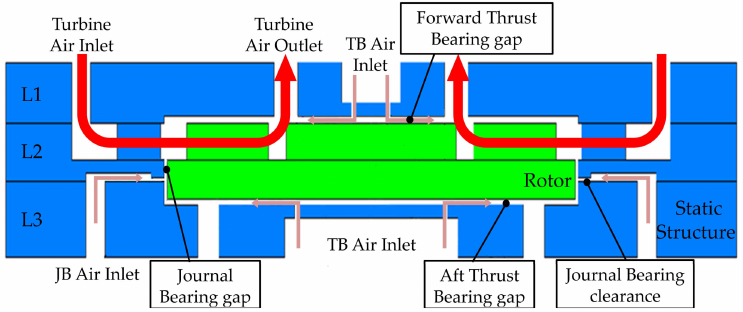
Figure 2. Cross section diagram of a bonded